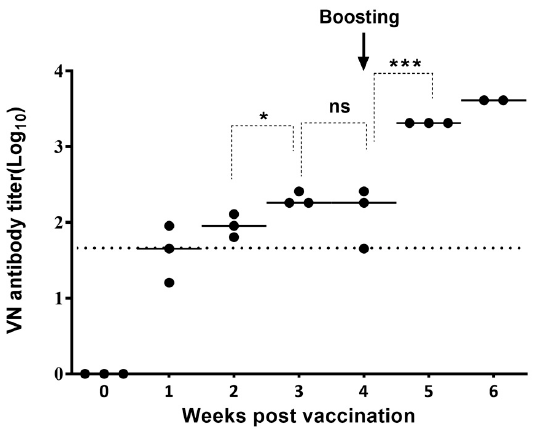
Figure 3. Induction of virus-neutralizing (VN) antibody in pigs vaccinated with the A/SKR/Yeoncheon/2017 (A-1) experimental vaccine. The virus neutralization test (VNT) was carried out using sera collected from pigs vaccinated with A/SKR/Yeoncheon/2017 (A-1) at 0, 1, 2, 3, 4, 5, and 6 weeks post-vaccination. The dotted line indicates the 1:45 (log 10 1.65) VN antibody titer cut-off level. Statistical analysis was conducted using an unpaired t -test (* p < 0.05, *** p < 0.005, ns: not significant). “Boosting” indicates the second vaccination.